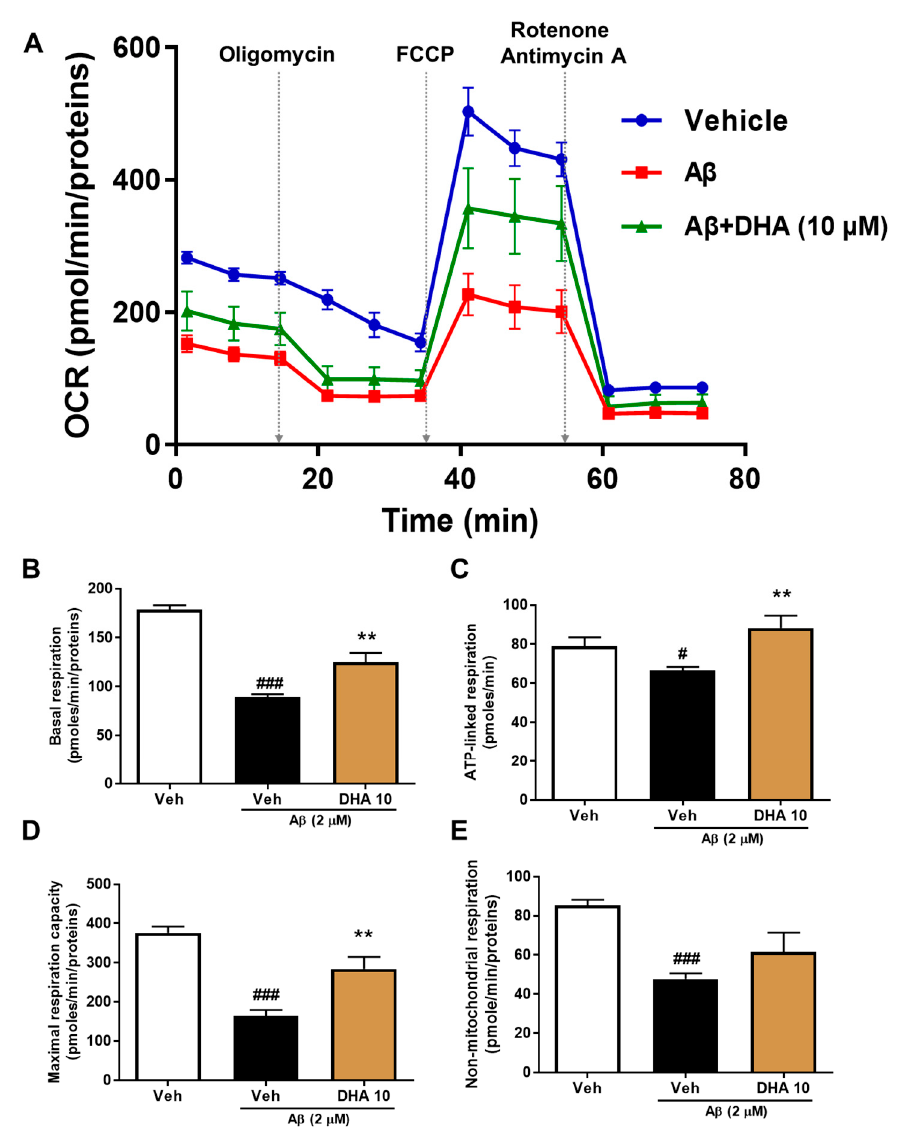
Figure 3. DHA alleviates A β -induced mitochondrial dysfunction in HT22 cells. ( A ) The OCR in HT22 hippocampal cell lines was measured using the Seahorse XFp analyzer after treatment with 2 µ M A β or A β + DHA (10 µ M). Basal respiration ( B ), ATP-linked reparation ( C ), maximal respiration capacity ( D ), and non-mitochondrial respiration ( E ) were derived by analyzing OCR values following the addition of FCCP (1 µ M), oligomycin (1 µ M), and rotenone (0.5 µ M) + antimycin A (0.5 µ M). Data are expressed as mean ± SEM. # p < 0.05 and ### p < 0.001: vehicle-treated cells versus A β -treated cells. ** p < 0.01.